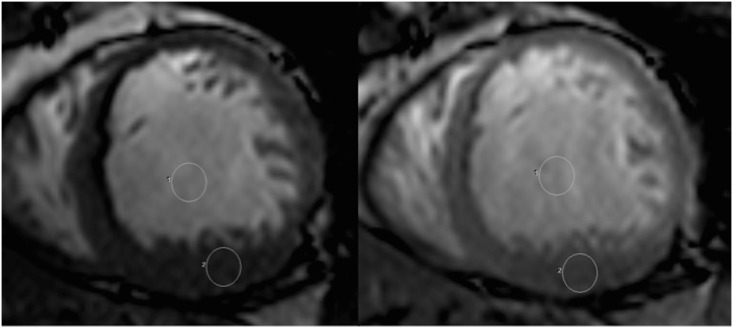
Placement of the ROIs in the left ventricular short axis before and after gadolinium injection.